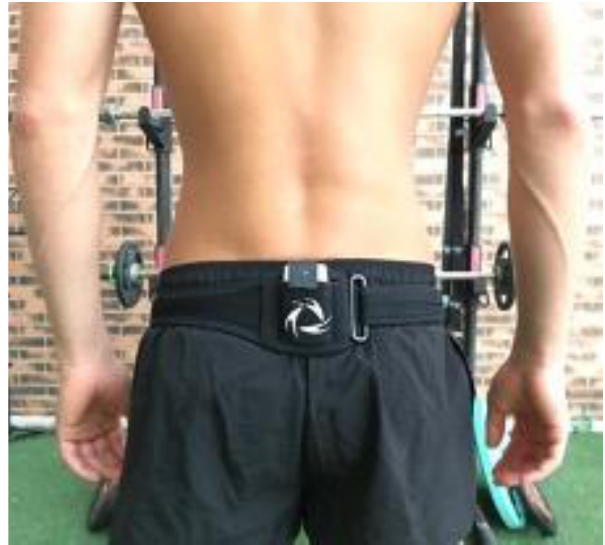
Figure 1. Placement of the IMU in